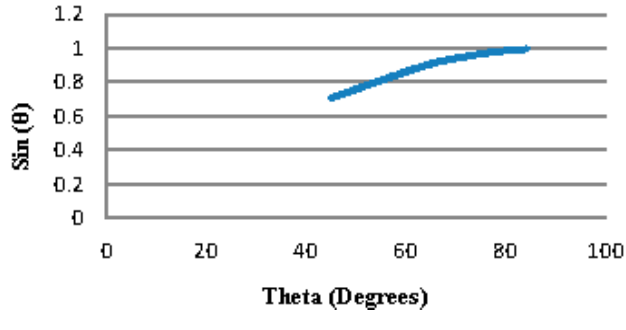
Figure 11. Variation of sin( θ ) with varying θ from 45° to 90°.